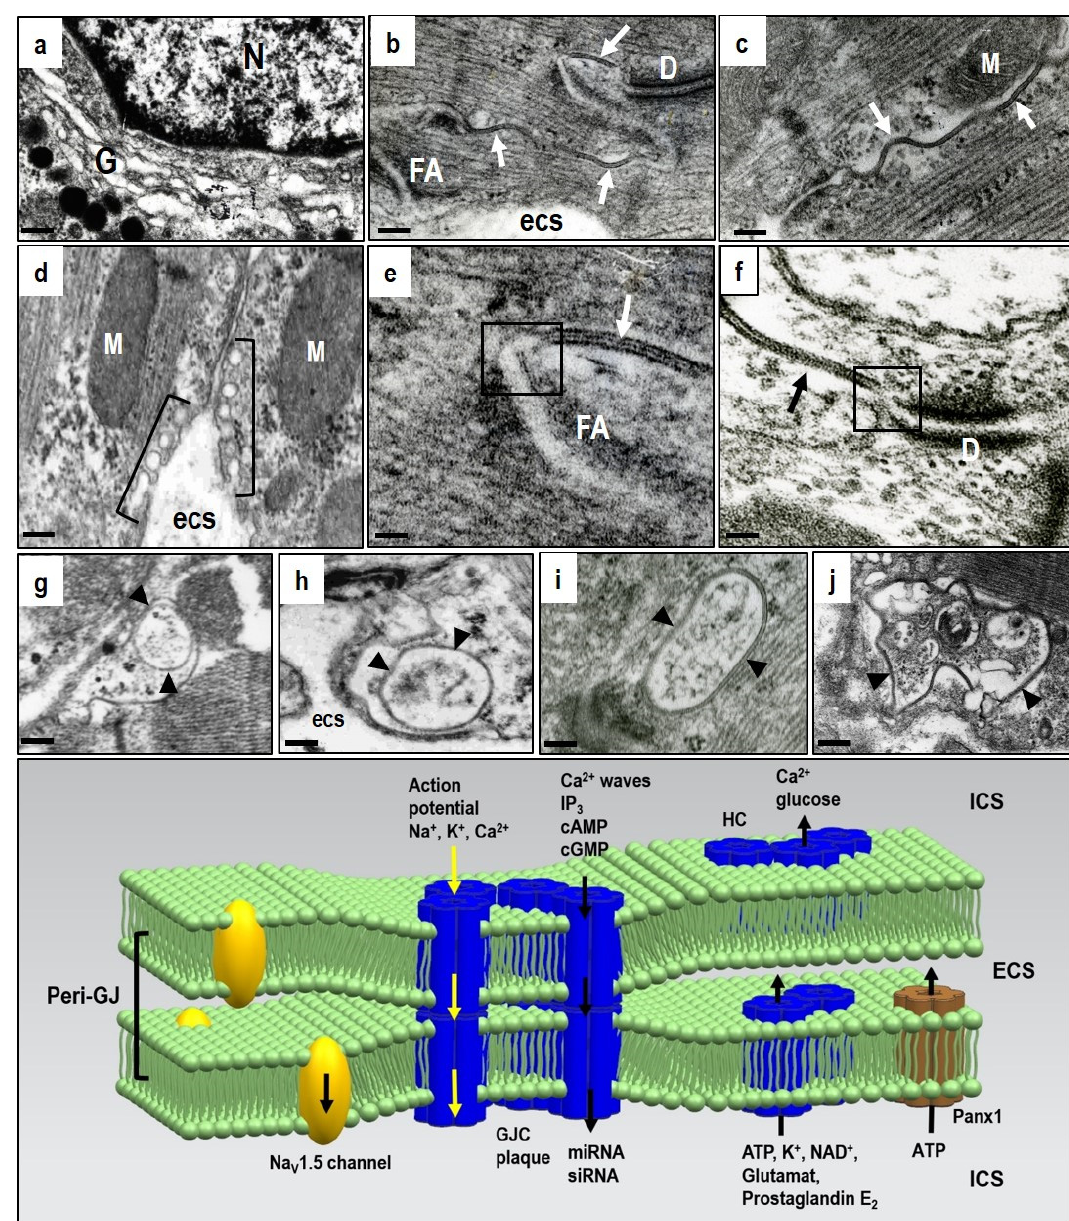
Figure 1. Electron microscopic images of the adult rat heart cardiomyocytes showing structures hosting Cx43. ( a )—Golgi compartment in which Cx43 is oligomerized to HCs; ( b – d )—post-Golgi HCs underwent targeted delivery to the particular membrane-subdomains, i.e., caveolae/rafts and gap junctions, close apposition of neighboring cardiomyocytes, which consist of paired HCs forming gap junction channels (GJCs). Gap junction plaques (arrows) are prevalent at the intercalated disc ( b ) and scarce at the lateral sides of the cardiomyocytes ( c ), while caveolae/rafts (brackets) are abundant at the lateral membranes ( d ). Peri-junctional plasma membranes (boxes in ( e , f )) contain undocked HCs and Panx1 channels. The internalization of gap junctions into annular profiles (arrowheads in ( g – j )) precedes degradation of HCs via proteasomal and lysosomal pathways. Abbreviations: G—Golgi compartment, N—nucleus, D—adhesive junction, desmosome, FA—fascia adherent junction, M—mitochondria, esc—extracellular space, scale bar—0.1 micrometer. The diagram demonstrates the putative topology of GJCs at the gap junction plaque, HCs and Panx1 and also the Na V 1.5 channels at the peri-junctional membranes together with transmitted ions and molecules; ICS—intracellular space, ECS—extracellular space. Tribulova, unpublished representative electron